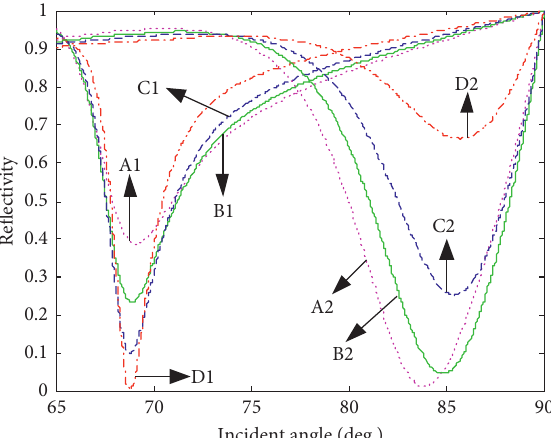
Figure 4: SPR spectrum for different thicknesses of Au layer for d � 40nm (curves A1 and A2), 45nm (curves B1 and B2), 50nm (curves C1 and C2), and 60nm (curves D1 and D2), as the case of n � 1.30 and n � 1.38 for sensing medium. The curves A1, B1, C1, and D1 stand for the refractive index of sensing layer n � 1.30, the curves A2, B2, C2, and D2 stands for the refractive index of sensing layer n � 1.38. The thickness is 15nm, 10nm, 1 × 0.65nm, and 3 × 1.6nm for TiO 2 , ZnO, MoS 2 , and GO layer,